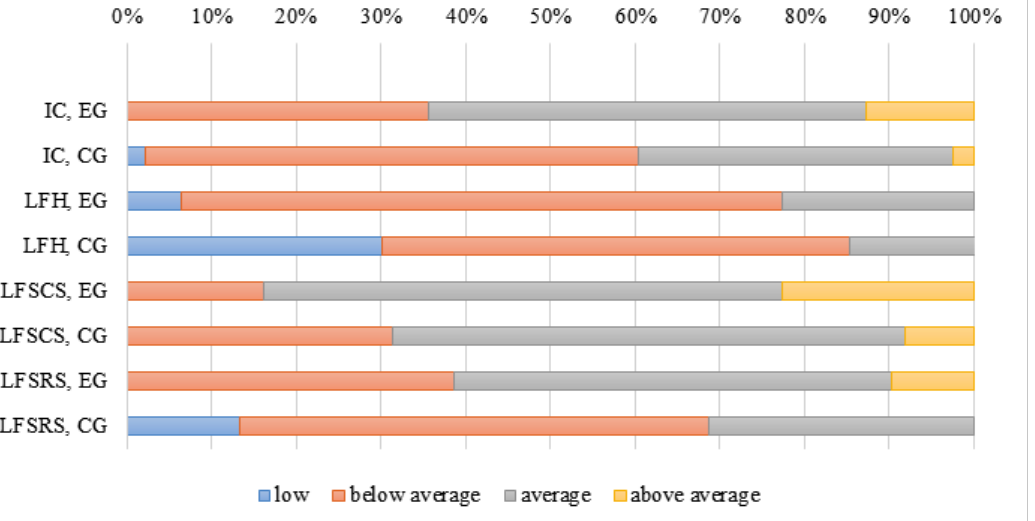
Fig. 3. Intragroup distribution of females of experimental (EG) and control (CG) groups by integrated indicators of physical and functional fitness at the end of the research, %: Note: IC – index of physical capacity; LFH – the level of physical health; LFScs – the level of functional state of the cardiovascular system; LFSrs – the level of functional state of the respiratory system; CG – control group; EG – experimental